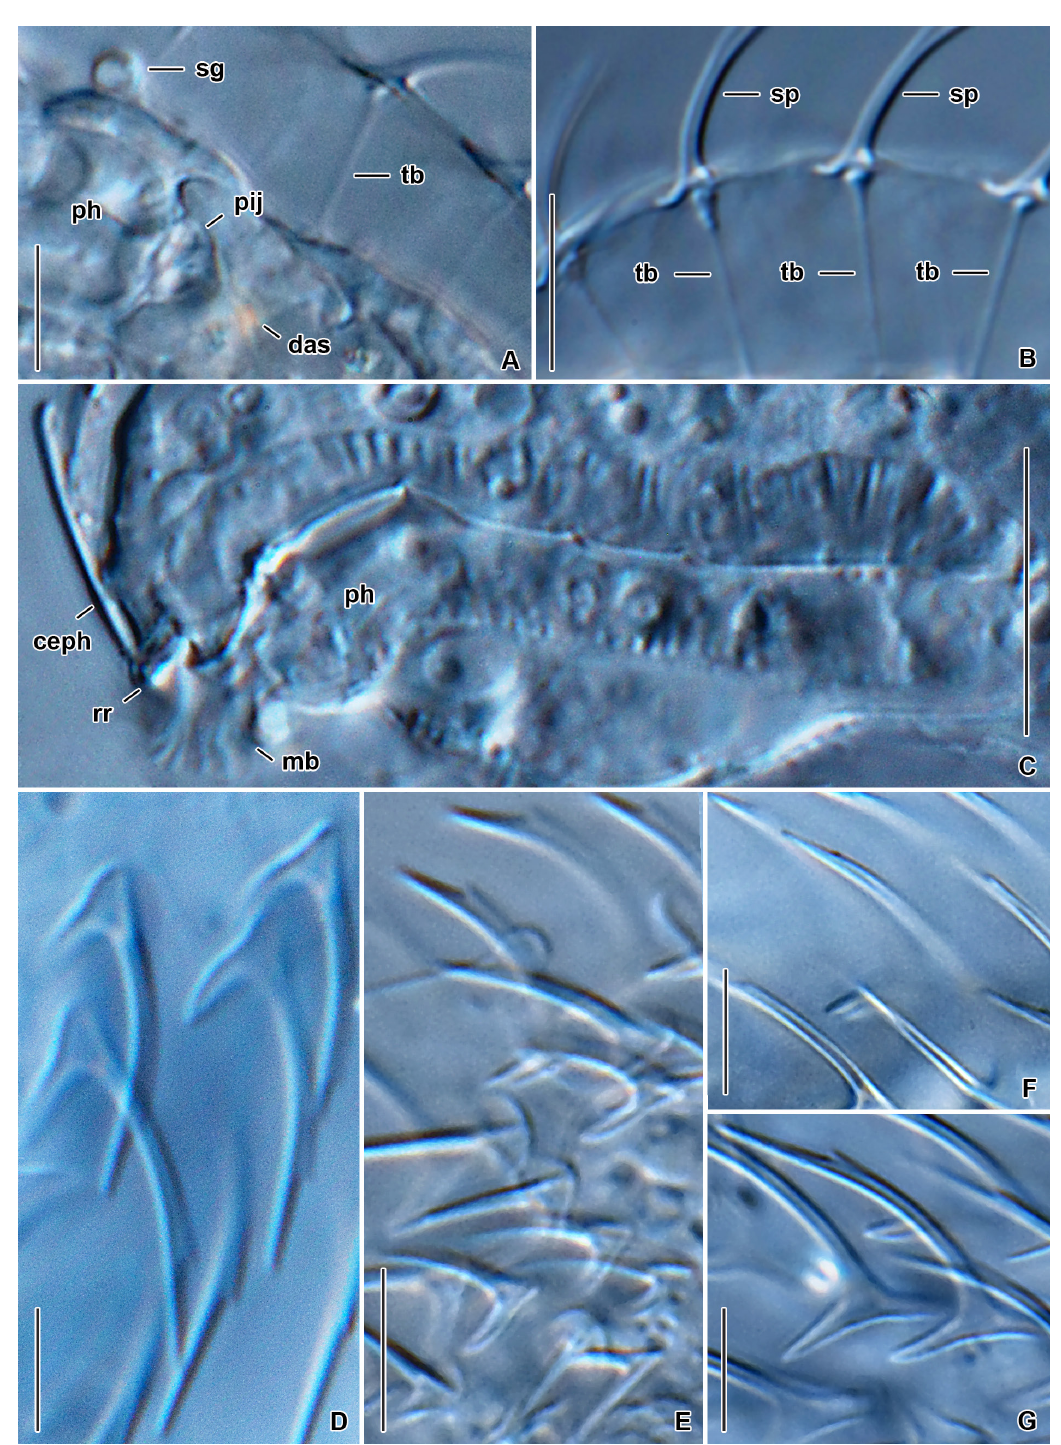
Fig. 17. Chaetonotus ( Hystricochaetonotus ) superbus sp. nov., differential interference contrast. A–B . Paratype (CU-FNS-22-06-20/PA). C–G . Holotype (CU-FNS-15-06-20/HO). A . Detail showing the salivary gland, pharyngeal-intestinal junction, and differentiated anterior section of the intestine. B . Detail showing the connection of transversal bands to the base of scales. C . Detail showing the anterior portion of the digestive tract. D . Head scales. E . Neck scales. F . Spines. G . Trunk spined scales. Scale bars: A–B, D‒G = 5 µm; C = 10